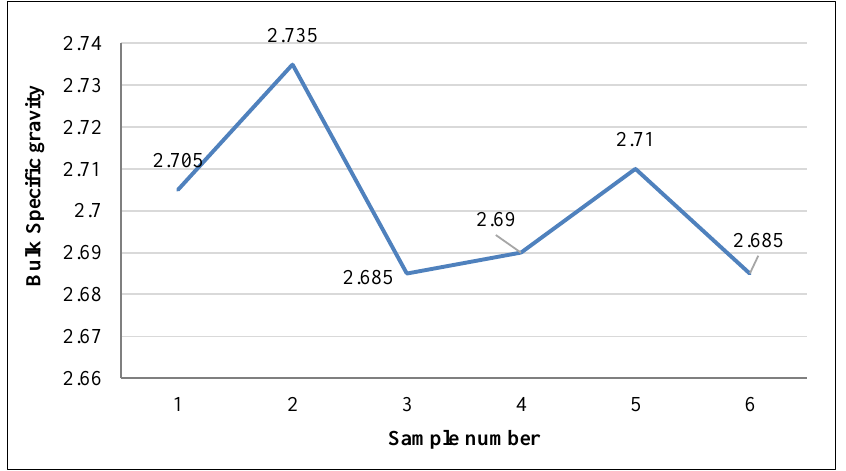
Figure 25. Bulk specific gravity values for six mixes